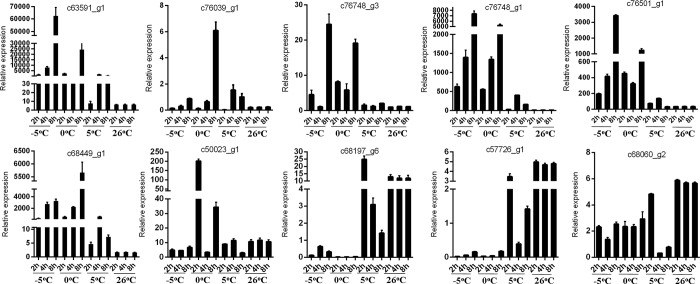
The expression of R. patientia genes in response to chilling at different temperature for 0 to 8 h as determined by qRT-PCR.